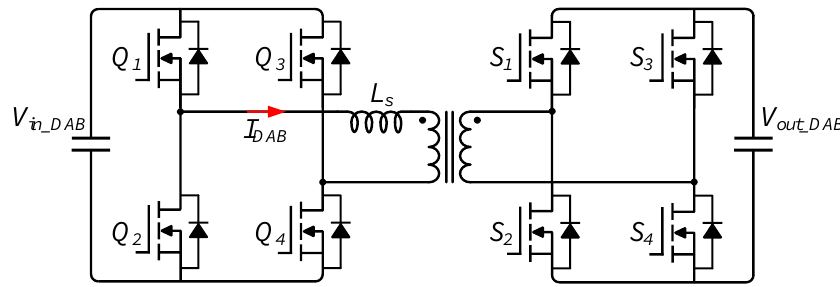
Figure 10. Schematic of dual-active-bridge (DAB) DC-DC converter.